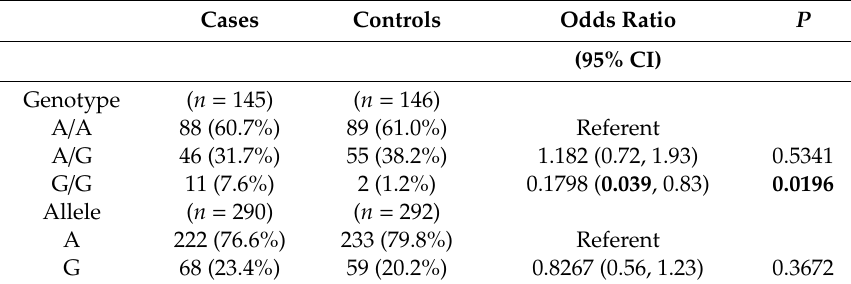
Table 1. Genotype and allele frequencies of rs933151 in control and ASD subjects. Cases